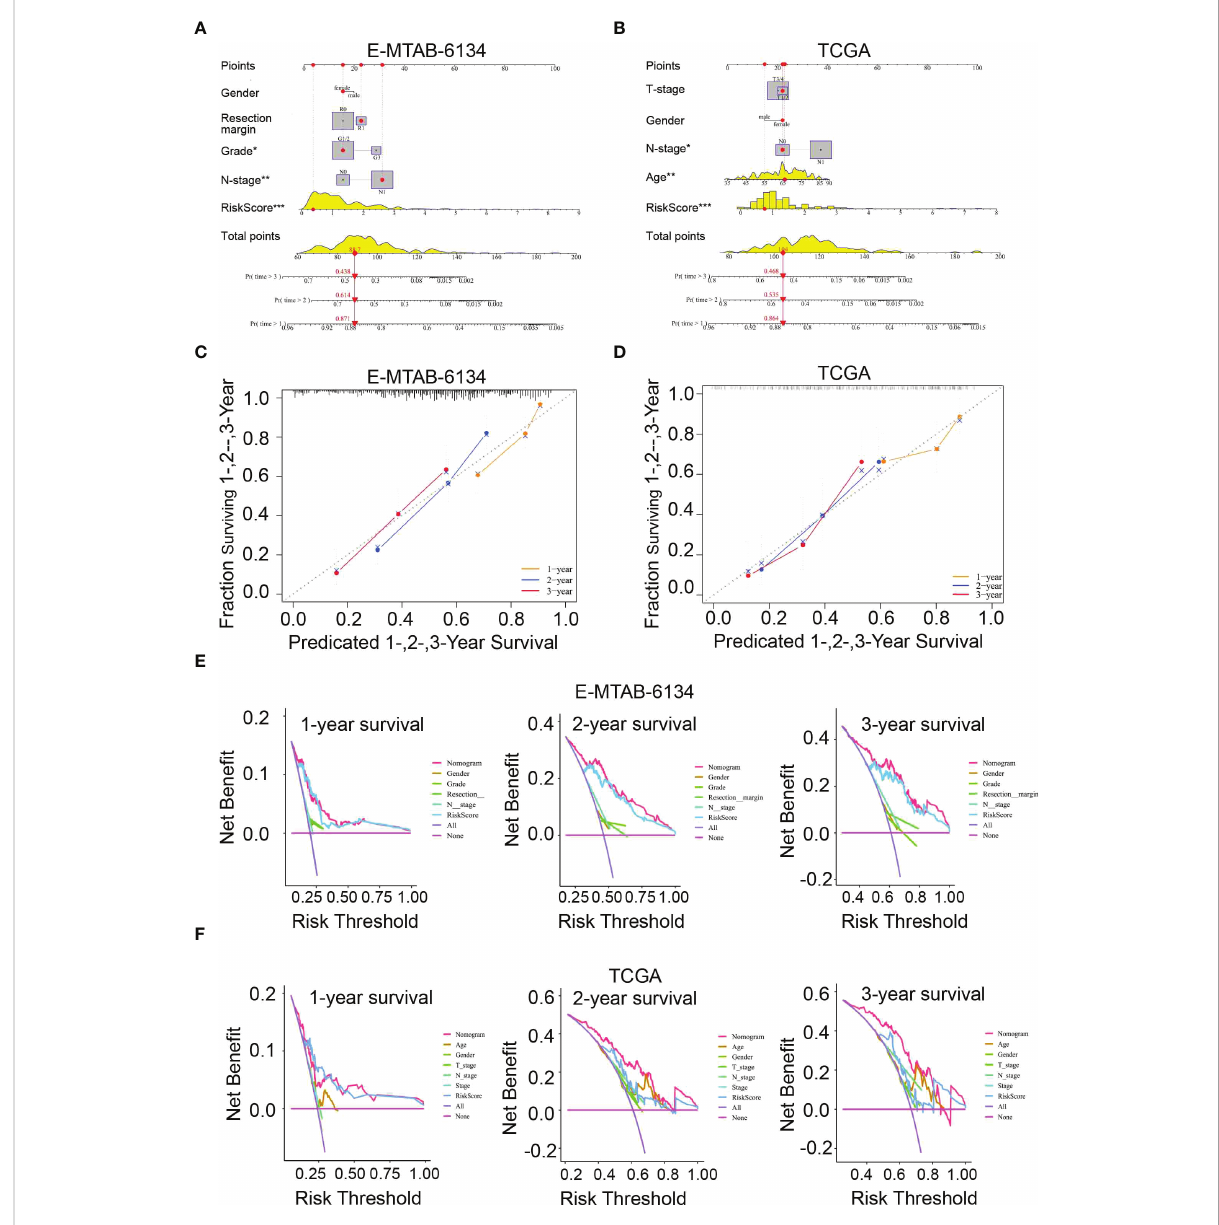
FIGURE 7 Nomogram for predicting 1-,2-, and 3-year OS. (A, B) Construction of a nomogram based on risk scores and other clinical factors. (C, D) The predictive accuracy of the nomogram veri fi ed by calibration curves. (E, F) DCA curves were used to compare the net survival bene fi t of the nomogram, risk score, and clinical